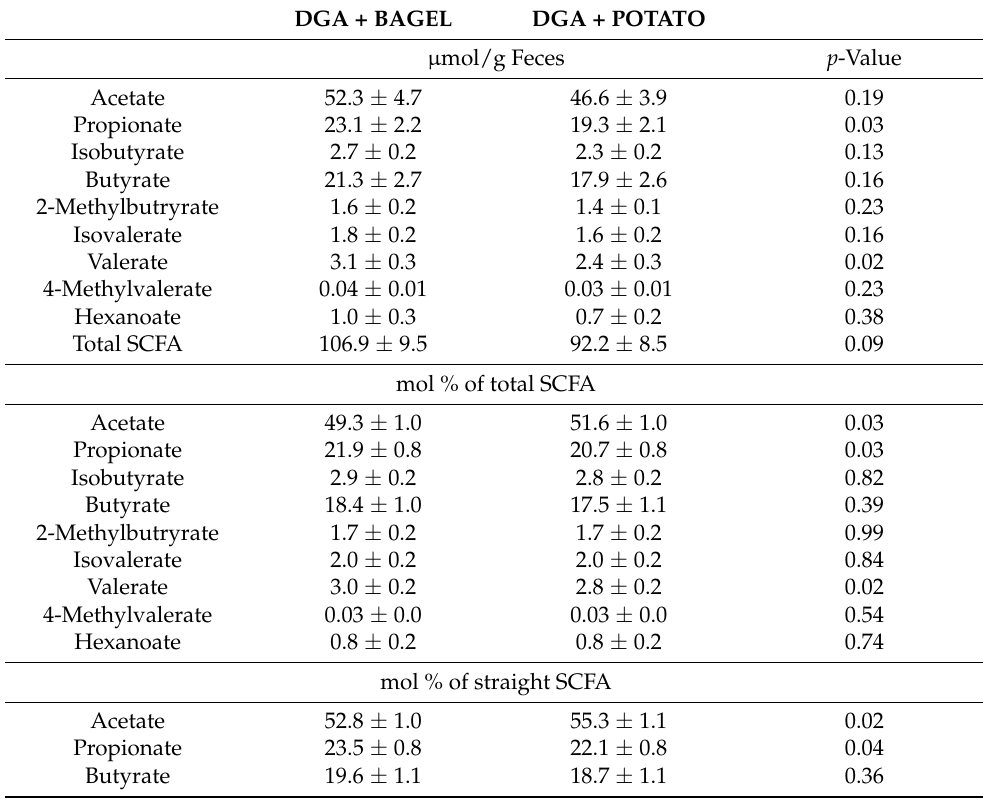
Figure 4. Postprandial endotoxemia and gut permeability in MetS persons who followed a DGA - based diet containing potatoes (DGA + POTATO) or bagels (DGA + BAGEL) for 2 w prior to completing simultaneous oral glucose tolerance and gut permeability tests. ( A ) Serum endotoxin and ( B ) endotoxin AUC 0–120 min during a 2-h postprandial period and ( C ) 24-h urinary L/M and S/E following the ingestion of 75 g of glucose and non-digestible sugar probes. Serum endotoxin (means ± SE, n = 27) are expressed as change from baseline (0 min) and were analyzed by 2-way RM ANOVA with Bonferroni’s post-test to assess effects due to time, treatment, and their interaction. p < 0.05 was considered statistically significant, and data are annotated (a > b > c) to visualize post-hoc effects due to time or time x treatment as appropriate. Endotoxin AUC 0–120 min was calculated using the trapezoidal rule. Endotoxin AUC 0–120 min and time-dependent analyses of L/M and SE were analyzed using a paired Student’s t -test (* p < 0.05). Abbreviations: AUC, area under the concentration curve; DGA , Dietary Guidelines for Americans ; L/M, lactulose/mannitol; and S/E, sucralose/erythritol. Table 5. Fecal SCFA profile of persons with MetS who consumed a DGA -based diet containing bagel or potato for 2 weeks 1,2